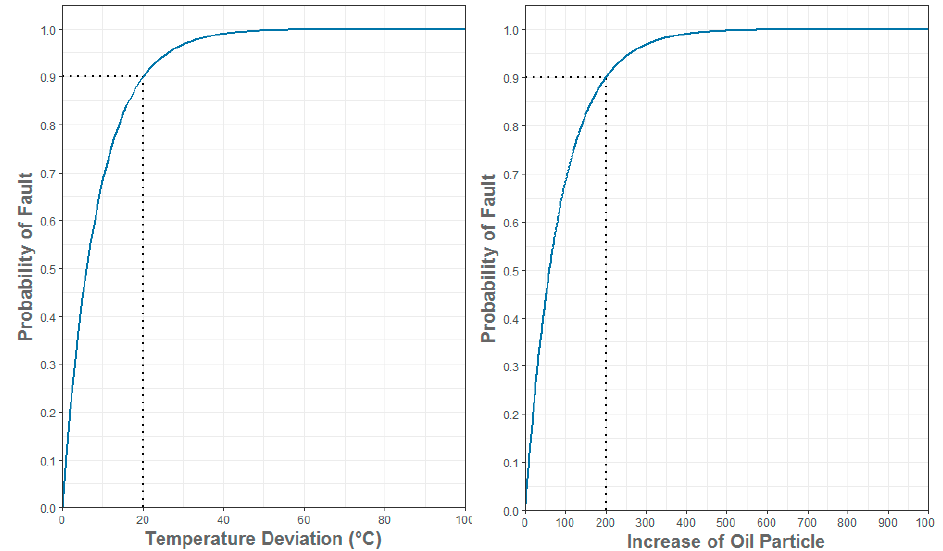
Figure 9. Probability of fault for temperature and oil particle diagnostic agents of the main bearing based on exponential rates calculated in Equation (6).